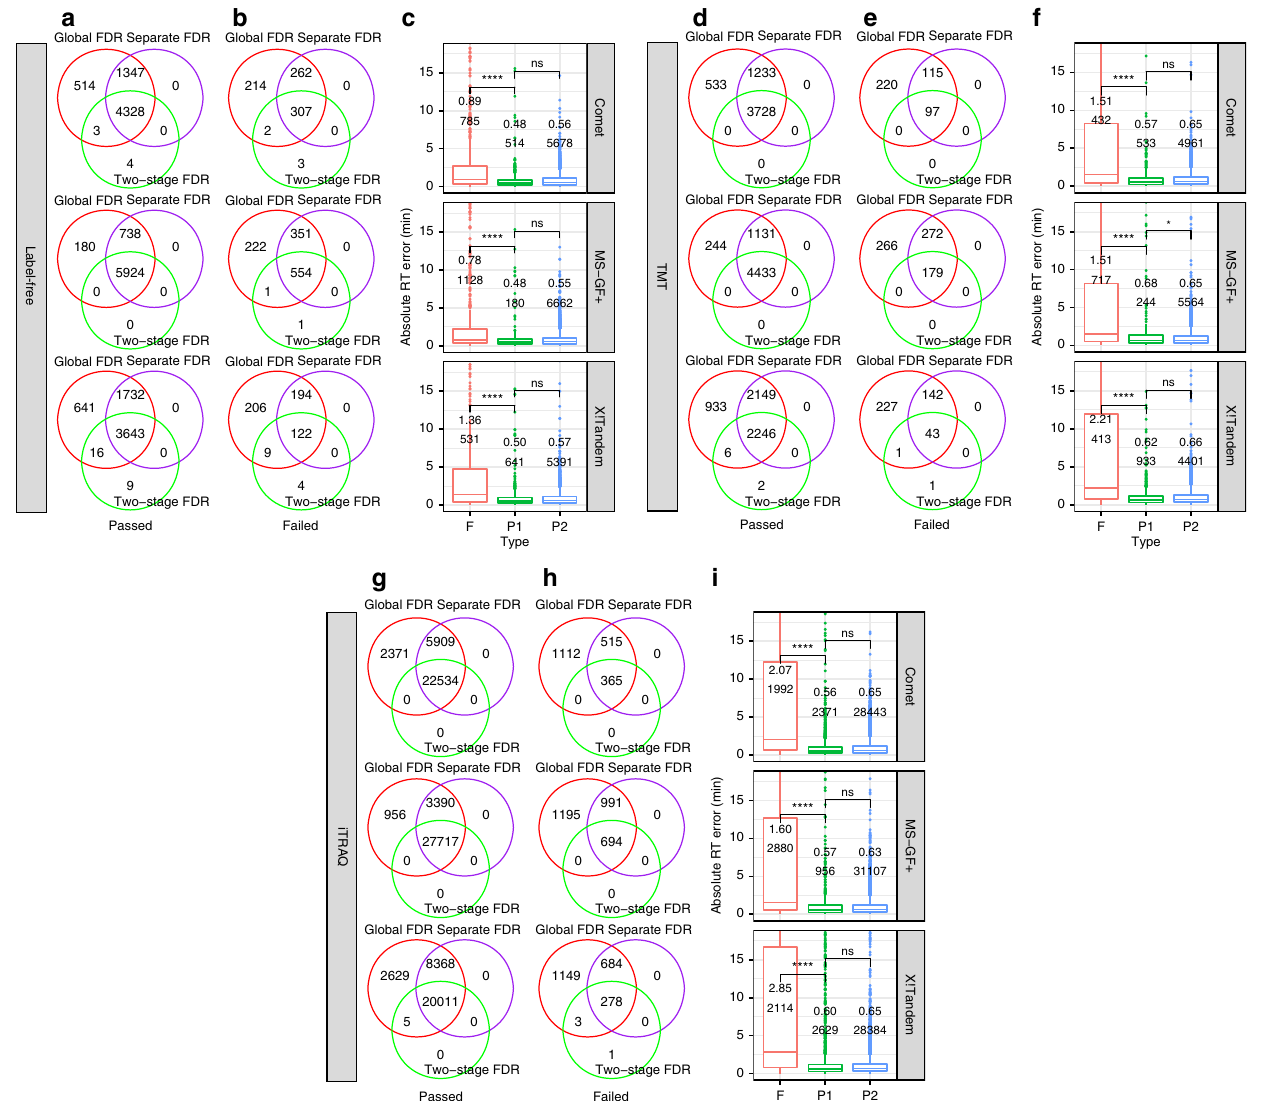
Fig. 5 Comparison of variant peptide identi fi cations with different levels of support. a – b Venn diagrams of variant peptides identi fi ed by